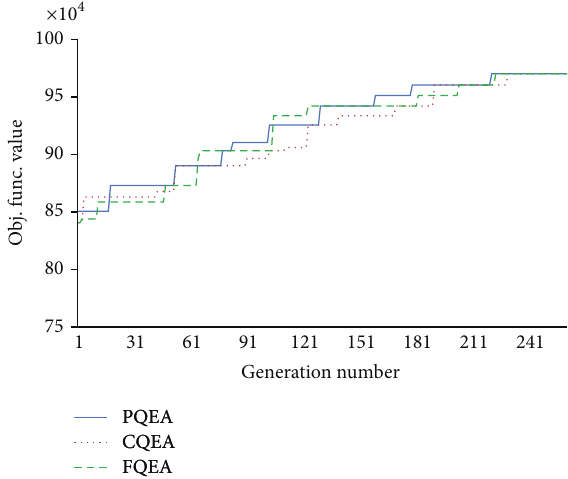
Figure 5: Convergence graph of PQEA, CQEA, and FQEA on COUNTSAT problem size, 𝑛 , being 20.